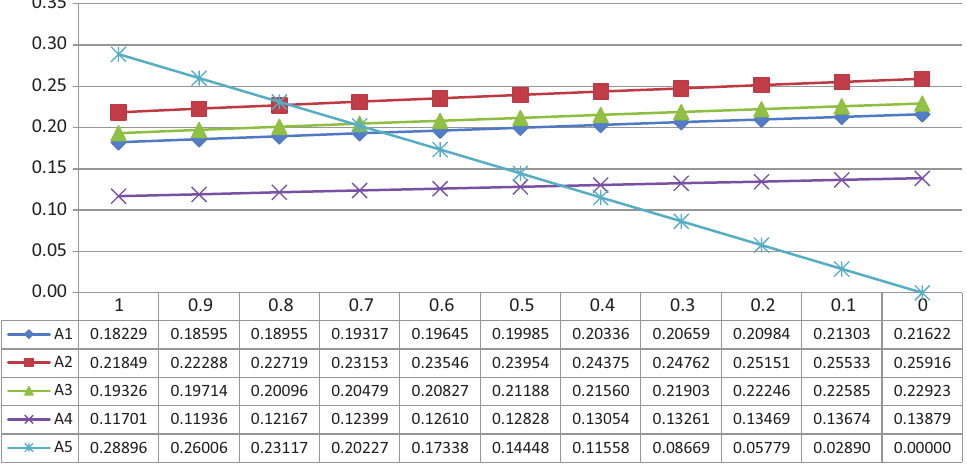
Figure 4. Results of the sensitivity analysis for the factor Motor Travel and Congestion Reduction Measures.